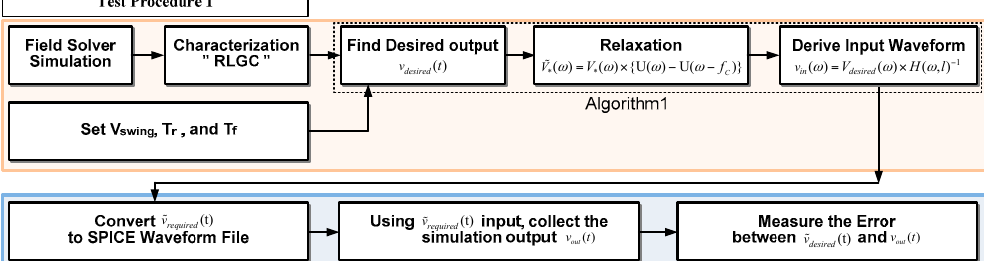
Figure 4. Test procedure for a single line.